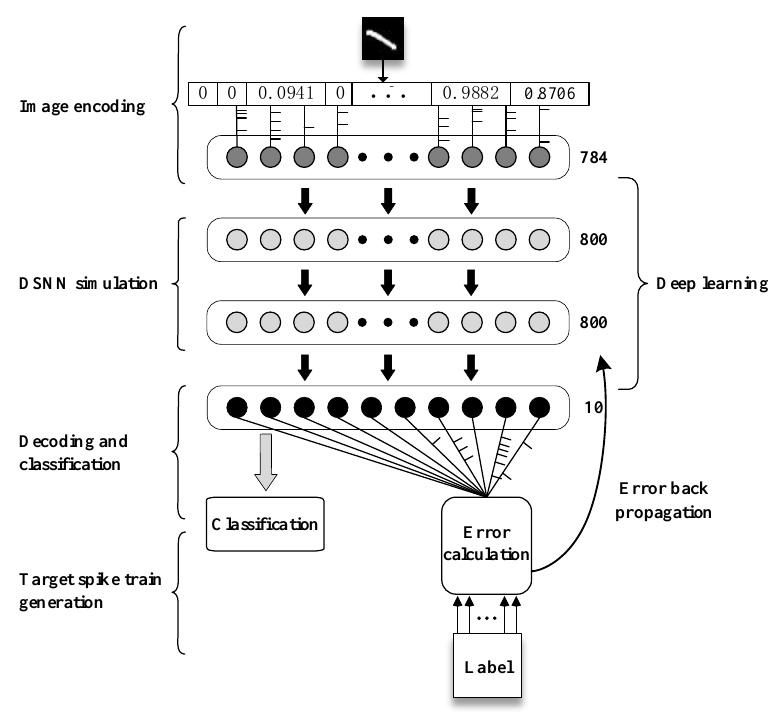
Figure 2. The MNIST classification computing framework based on DSNNs.